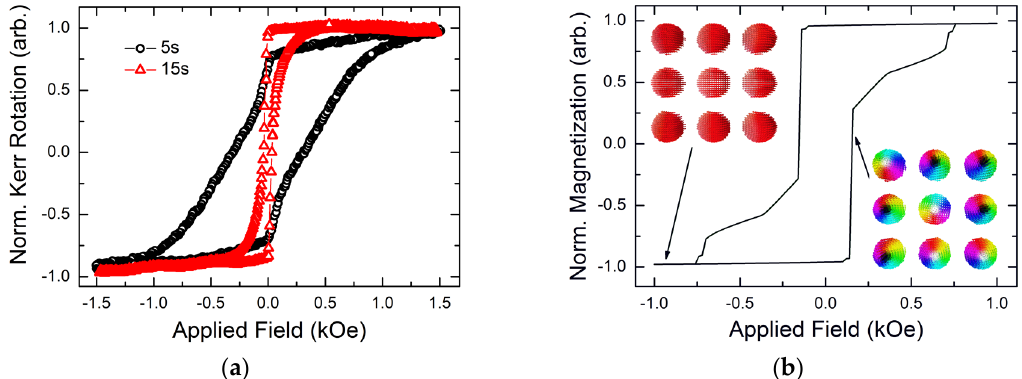
Figure 4. ( a ) Hysteresis curves obtained from MOKE measurements in samples with an electrodeposition time of 5 s and 15 s, under and over the percolation threshold, respectively, and ( b ) Theoretical hysteresis curve realized by micromagnetic simulation in an array of hemispheres with 90 nm diameters. The inset in ( b ) shows the saturated magnetization (upper left) and magnetic vortex ground state (lower right).